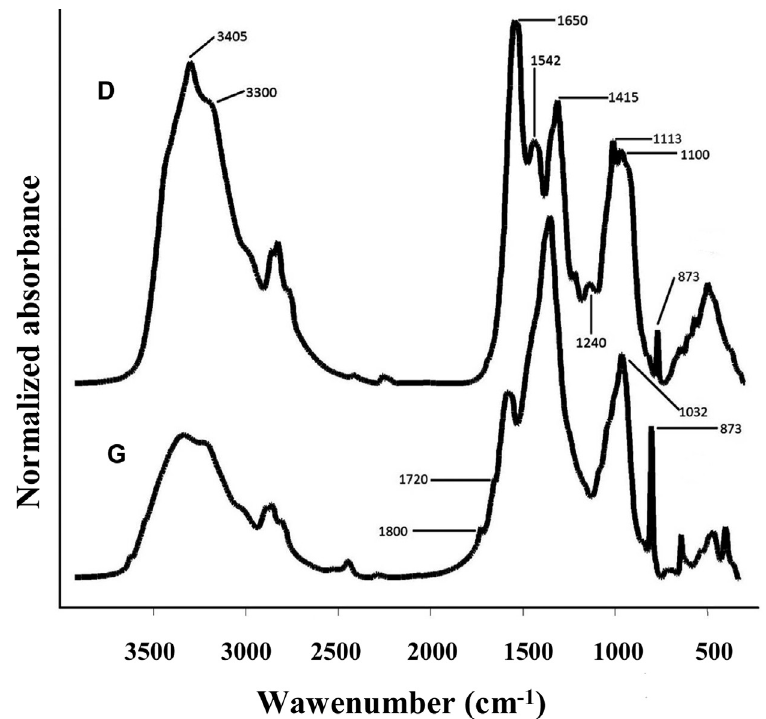
Figure 2. IR spectra of the samples of solid phase of M . graniger graniger ( G ) and M . graniger dragani ( D